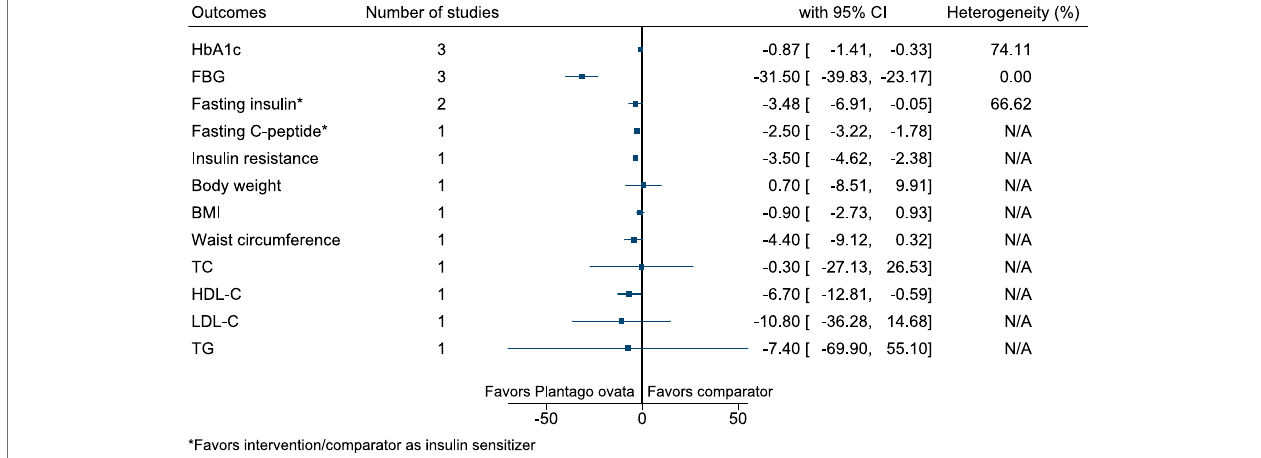
FIGURE 25 | Plantago ovata — Summary forest plot.